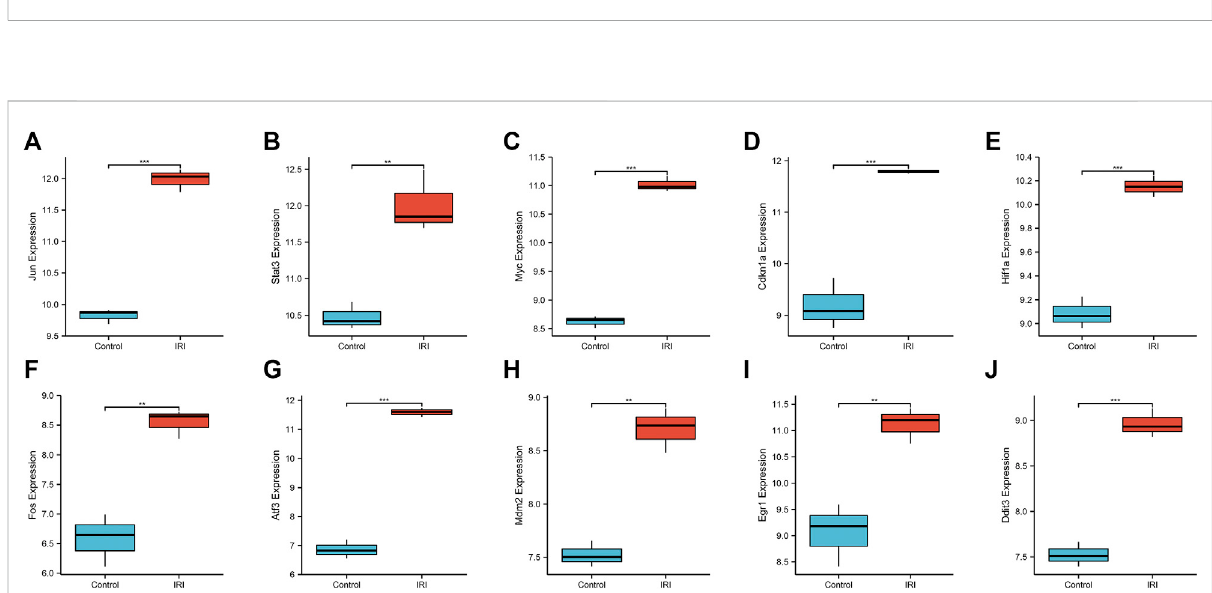
FIGURE 11 Expression levels of 10 hub genesin theGSE131288 dataset. Jun (A) , Stat3 (B) , Myc (C) , Cdkn1a (D) , Hif1a (E) , Fos (F) , Atf3 (G) , Mdm2 (H) , Egr1 (I) ,and Ddit3 (J) .DifferentialexpressionanalysisintheIRI-AKIgroupvs.controlgroupintheGSE131288 dataset.Note:*, p < 0.05;**, p < 0.01;***, p <